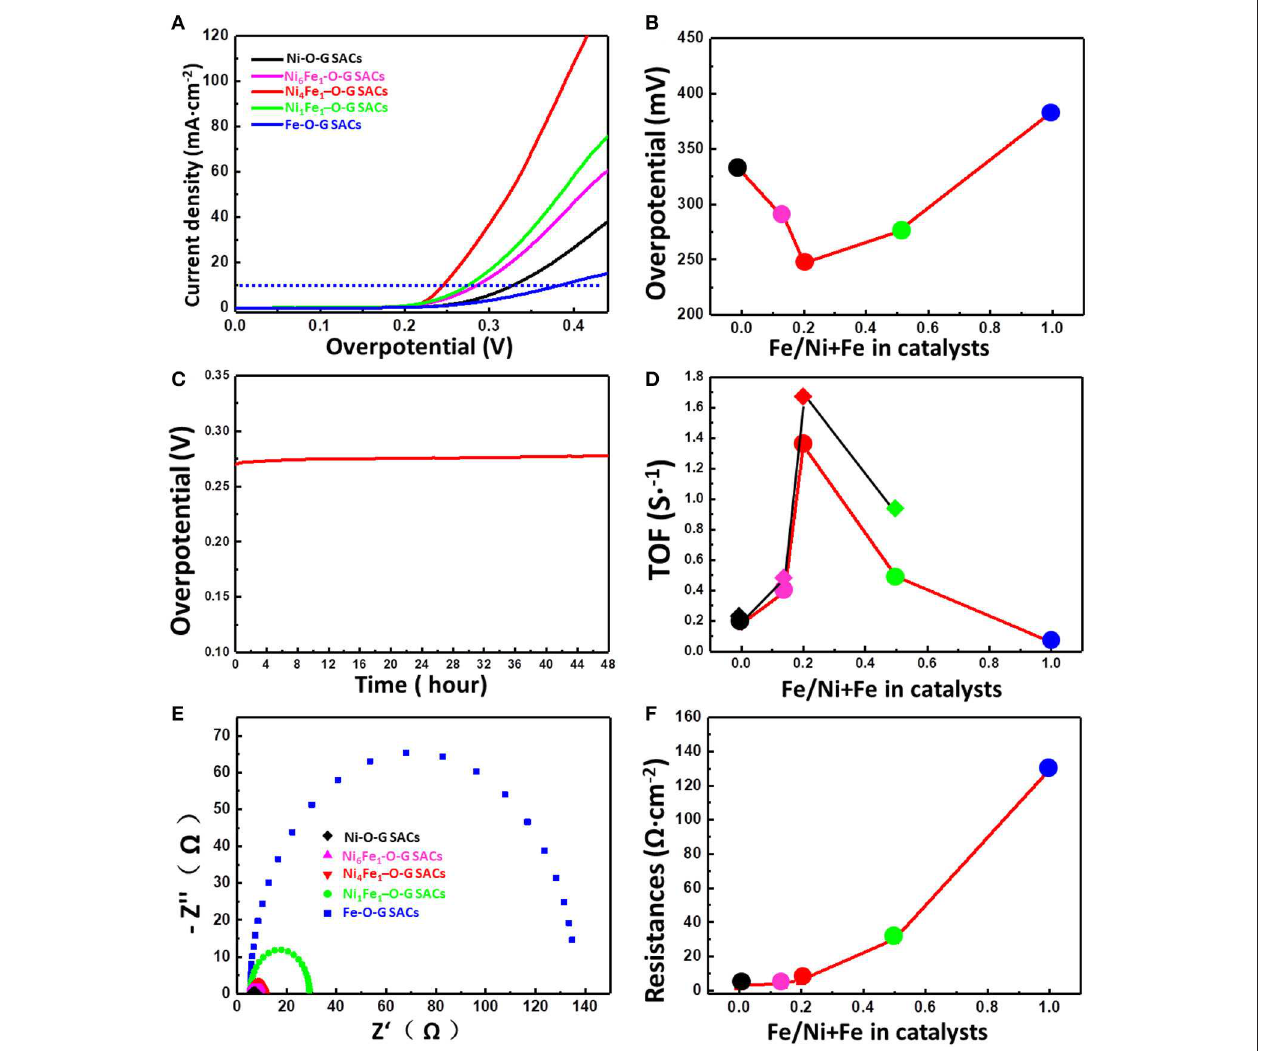
FIGURE 4 | (A) The OER polarization curves of Ni, Fe-O-G SACs with different Ni, Fe ratio (Ni, Ni 6 Fe 1 , Ni 4 Fe 1 , Ni 1 Fe 1 , Fe) obtained at scan rate of 2mV s − 1 and 80% iR correction. (B) The corresponding required overpotential of Ni, Fe-O-G SACs for 10mA cm − 2 current density. (C) Chronopotentiometric curve of Ni 4 Fe 1 -O-G SACs maintained at 20mA cm − 2 current density, in 1M KOH, with 80% iR correction. (D) The TOF value at 300mV overpotential of Ni, Fe-O-G SACs with different Ni, Fe ratio (Ni, Ni 6 Fe 1 , Ni 4 Fe 1 , Ni 1 Fe 1 , Fe), obtained at scan rate of 2mV s − 1 and 80% iR correction. (E) Nyquist plots of Ni, Fe-O-G SACs with different Ni, Fe ratio (Ni, Ni 6 Fe 1 , Ni 4 Fe 1 , Ni 1 Fe 1 , Fe). (F) The corresponding charge